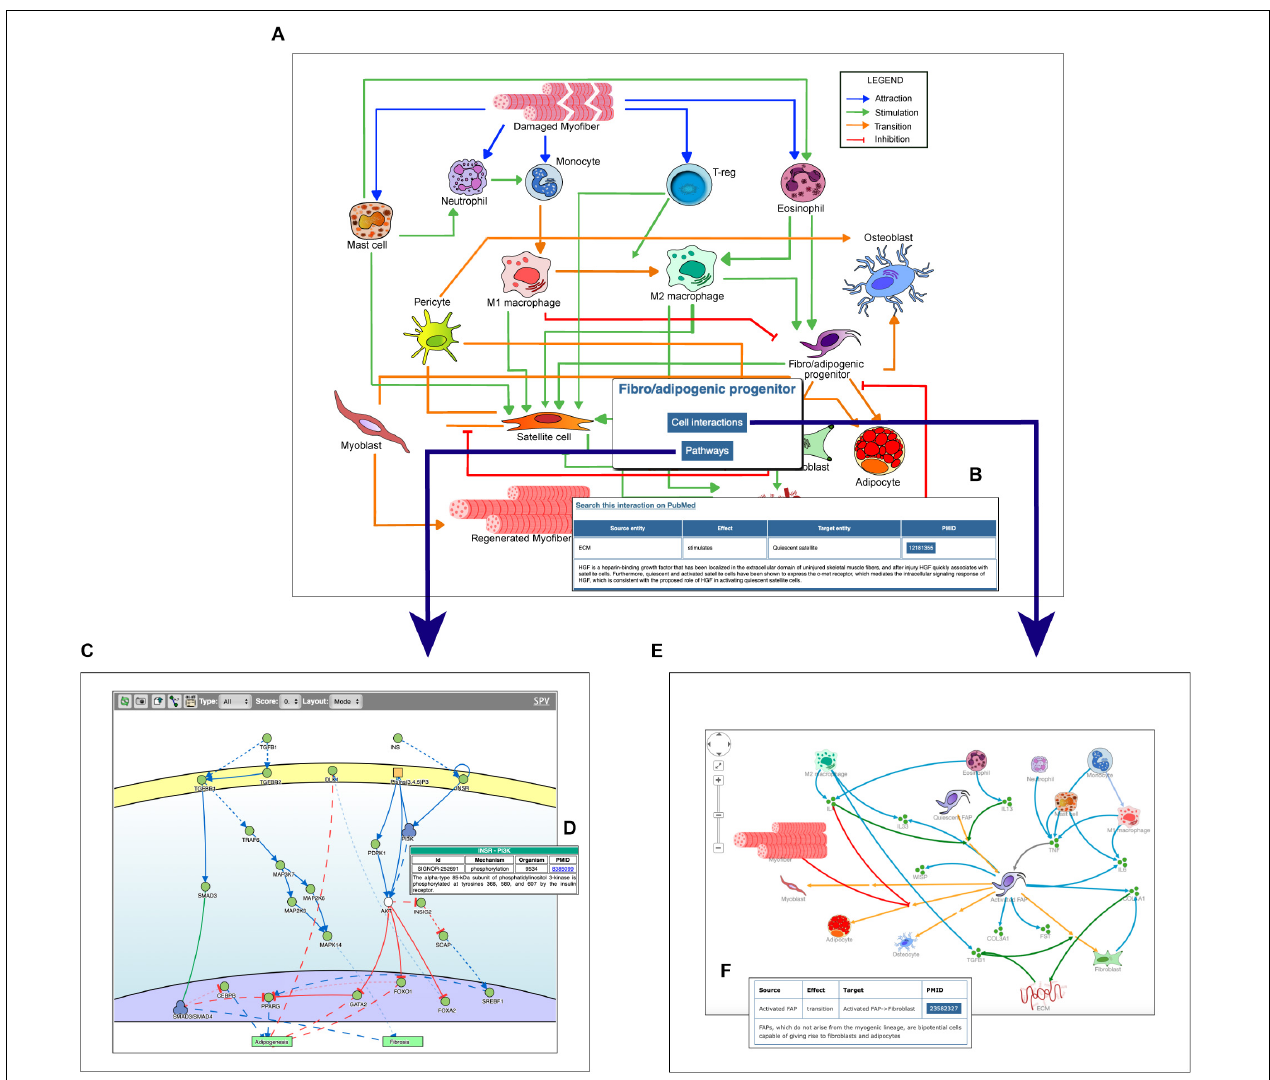
FIGURE 2 | Navigating the Myo-REG resource. (A) In the homepage a network of the cell interactions occurring in muscle regeneration is the main entry point to the information annotated in Myo-REG. By clicking on any edges, a pop-up window is displayed (B) showing the annotation for the selected interaction. By clicking a cell icon, a pop-up window is displayed offering the possibility to select either the “Cell interactions” or the “Pathways” tabs. (C) By selecting the pathway tab the user can choose to display a network representation of the pathways that are relevant for that cell type. (D) The annotation of an interaction (e.g., INSR-PI3K) displayed after clicking the edge on the graph. (E) The cell–cell interactions graph displayed for a selected cell type (FAP). (F) The annotation of an interaction displayed after clicking on an edge of the graph. Edge colors represent distinct interaction types according to the legend displayed on the top-left corner of the graph. Icons with three green circles represent cytokines participating in the process of muscle